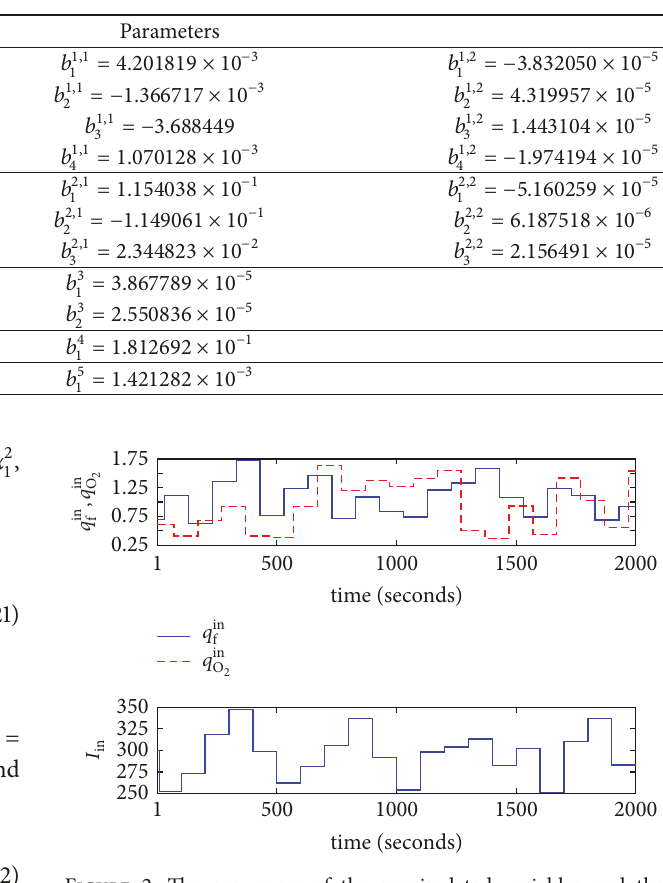
Figure 2: The sequences of the manipulated variables and the disturbance used for dynamic